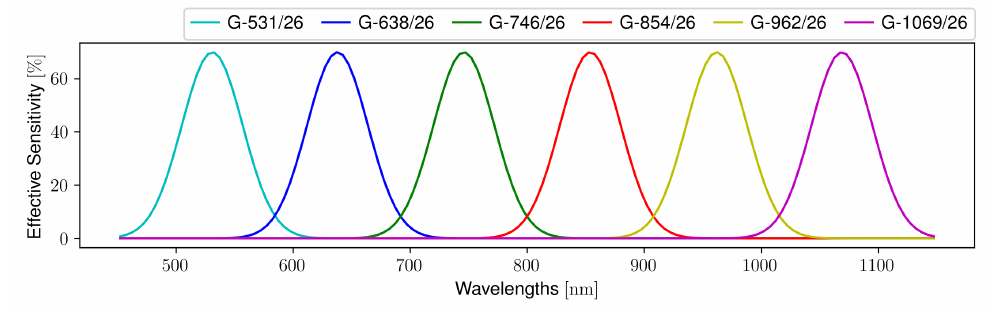
Figure A1. Gaussian observation bands denoted as G- λ centre / σ